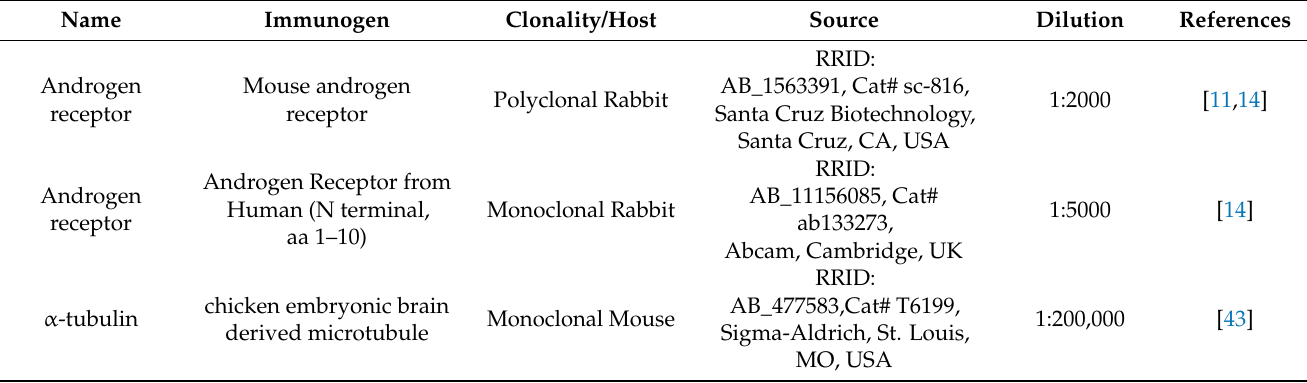
Table 1. Primary antibodies used in the present